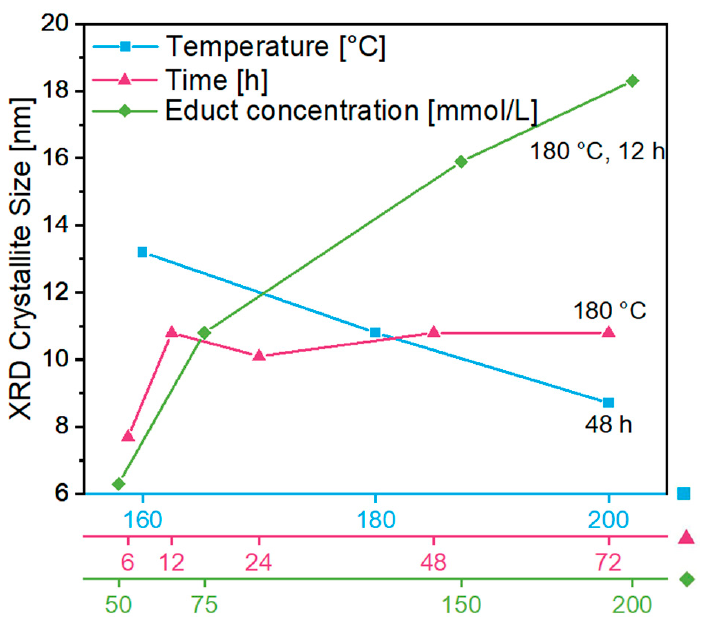
Figure 2. XRD crystallite size of the obtained gel products after drying to powders as a function of different synthesis parameters: effect of synthesis temperature at a reaction duration of 48 h (blue squares), influence of reaction duration at a synthesis temperature of 180 ◦ C (rose triangles) and effect of the In(acac) 3 concentration at 180 ◦ C for 12 h (green diamonds).